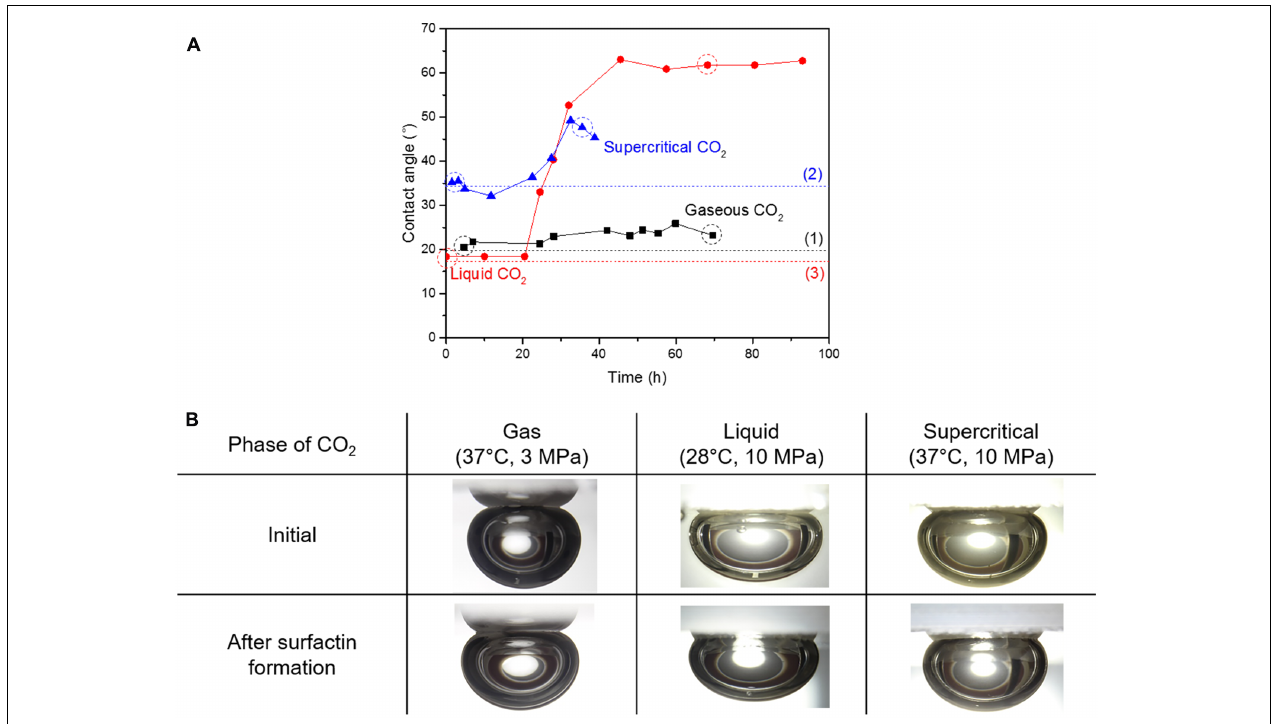
FIGURE 4 | (A) Variations in contact angle of CO 2 -brine-quartz with the surfactin production, and (B) the digital images of sessile drops of CO 2 in contact to the quartz disk before and after the surfactin production. Note: The dotted lines indicate the contact angle values from previous literature; the value for gaseous CO 2 (1) is from Kim and Santamarina (2014) and the values for liquid and supercritical CO 2 (2, 3) are from Sarmadivaleh et al. (2015). The droplet images in B correspond to the dotted circles in A .